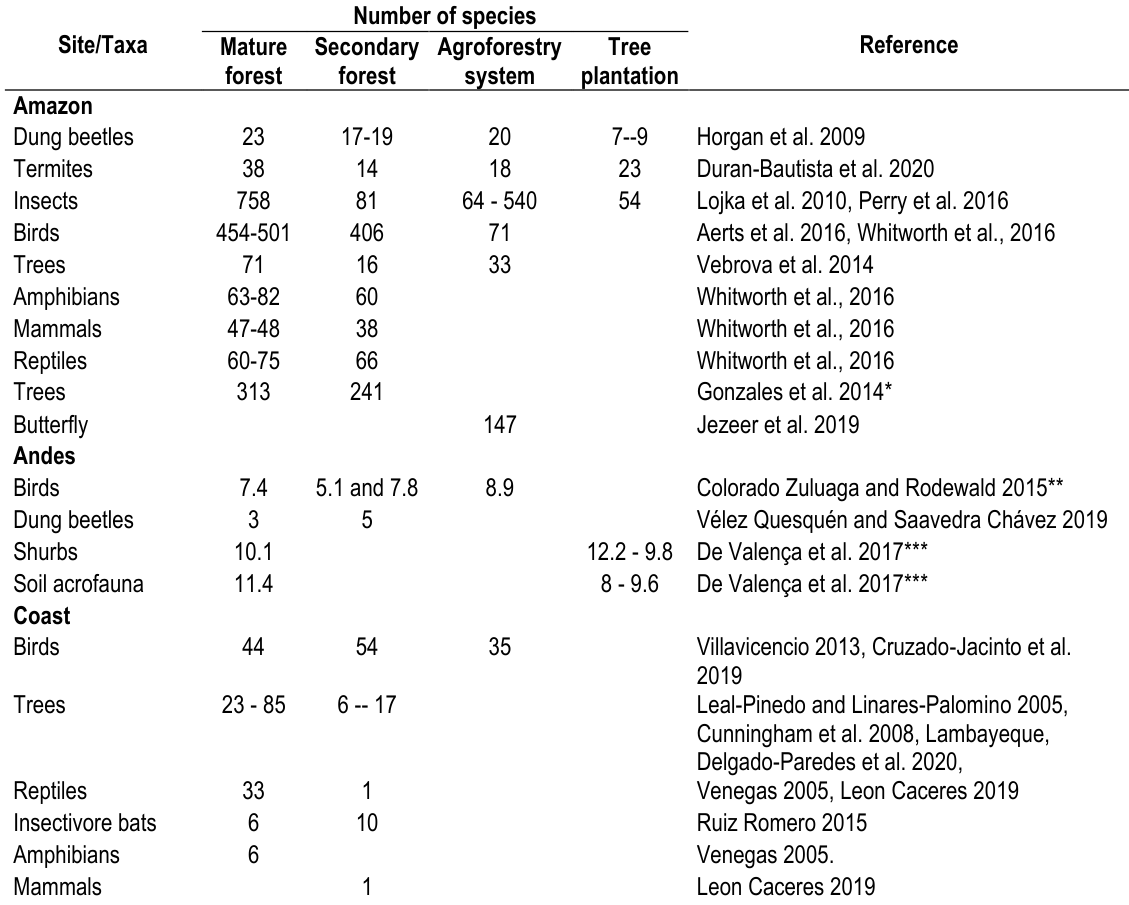
Table A2 . Number of species reported in different forest types and